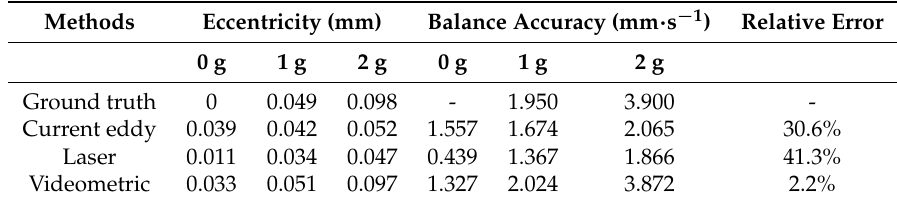
Table 2. Accuracy comparison of three methods.